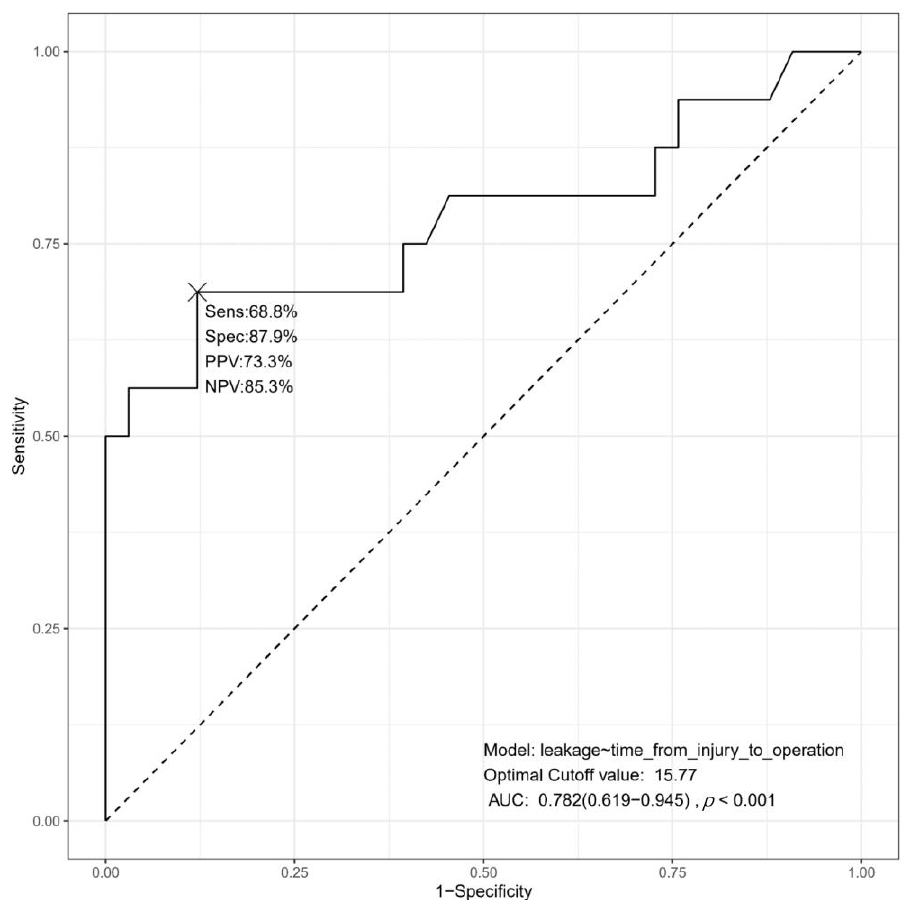
Figure 2. Diagnostic accuracy of time from injury to initial operation (hour) to detect the postoperative duodenal leakage. Optimal cutoff value is 15.77 h.